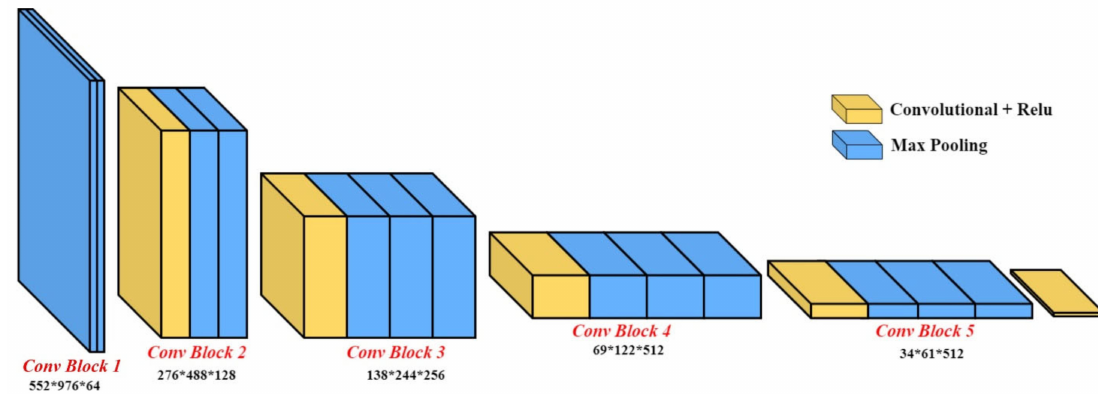
Figure 6. Pre-trained VGG-16